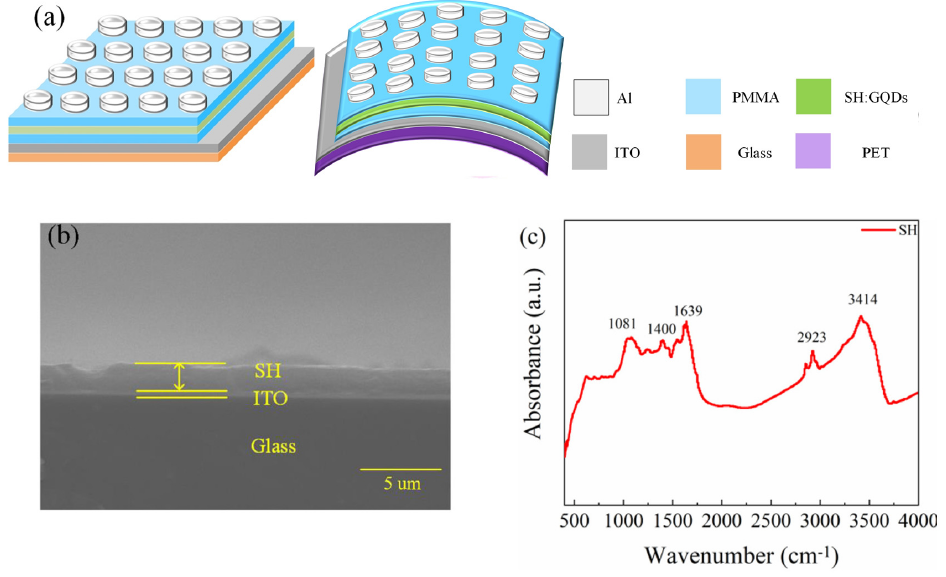
Figure 1. ( a ) Schematic diagram of the structure of floating-gate memristors. ( b ) SEM cross-section image of SH thin film. ( c ) Fourier infrared spectroscopy of SH thin films.